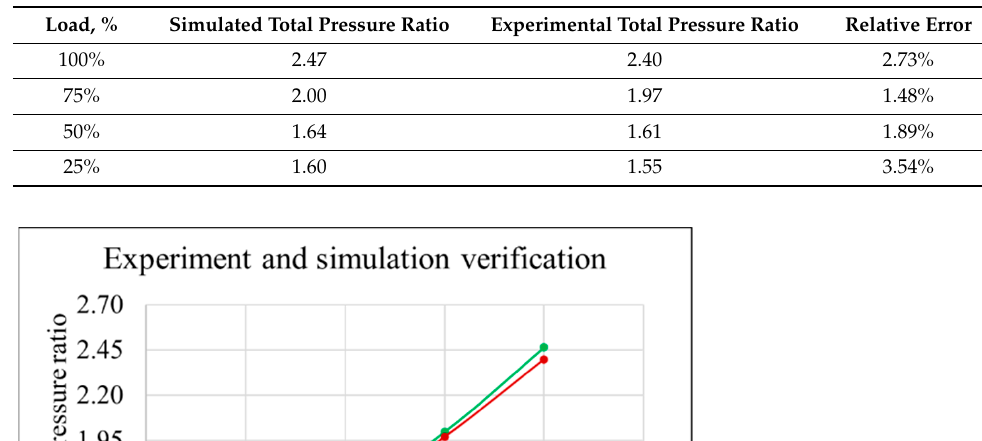
Figure 8. Schematic diagram of mesh independence test. Table 6. Comparison of total pressure ratio between CFD simulation and Experiment.